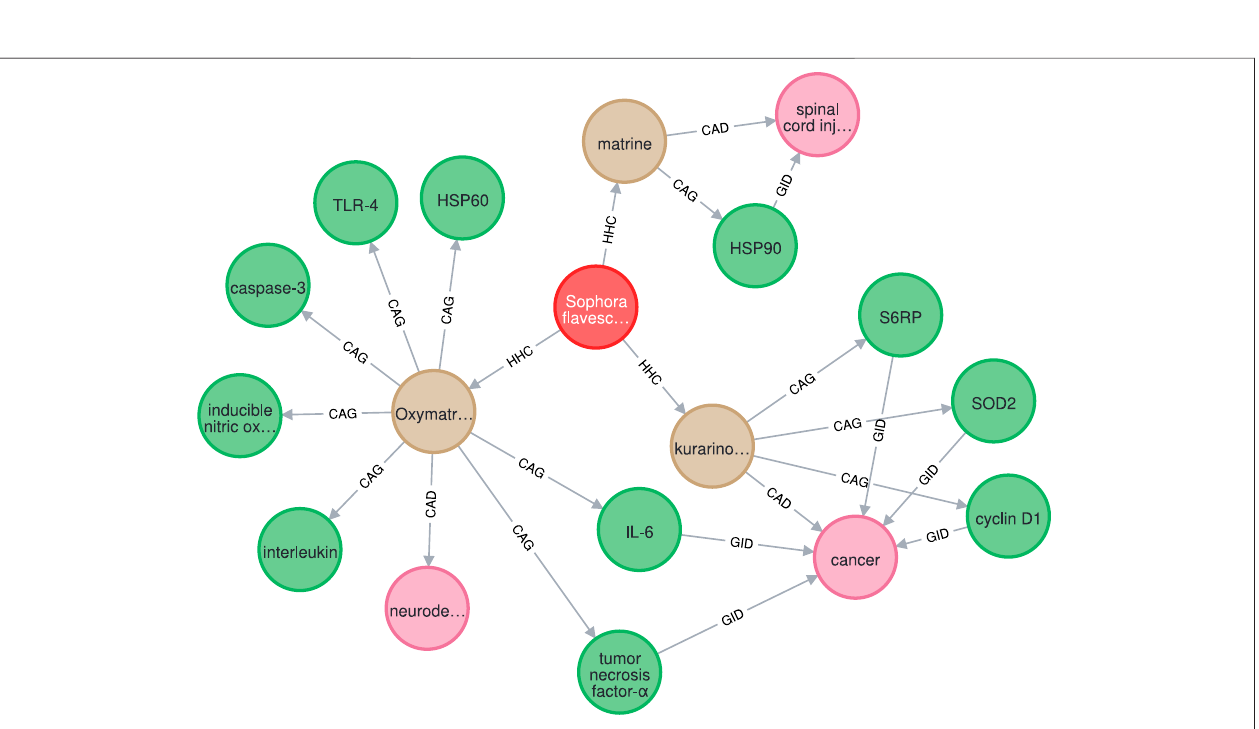
Frontiers in Genetics |